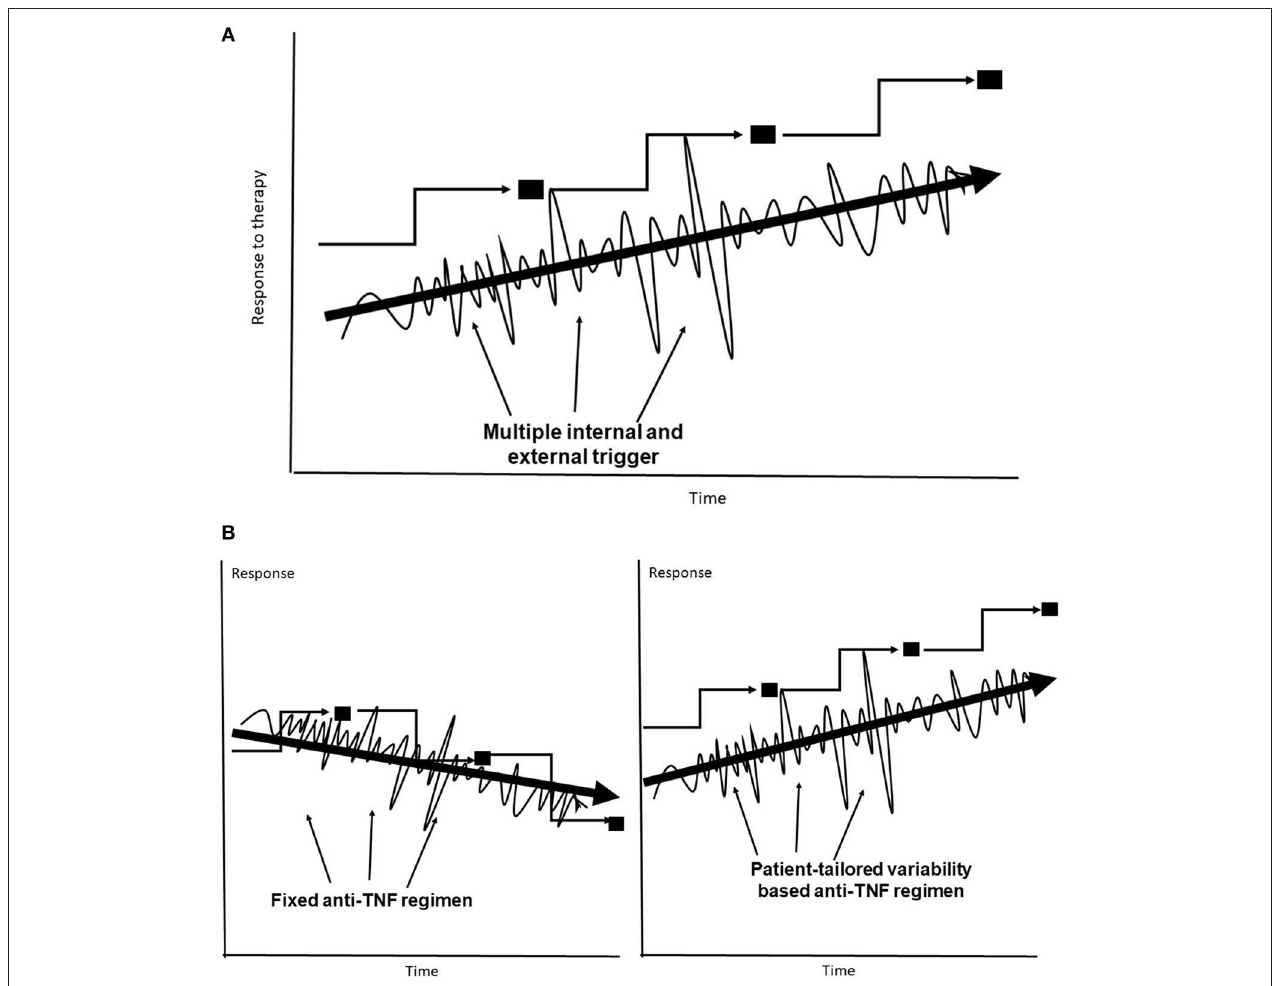
FIGURE 1 | (A) The body’s trajectory of compensatory adaptation in response to multiple internal and external triggers uses variability to reach a new steady state. (B) Fixed dosing may sometimes jeopardize the response to anti-TNF–based therapies, leading to lower steady states. Subject-tailored patterns of variability are introduced into anti-TNF administration along the trajectory for achieving an improved steady